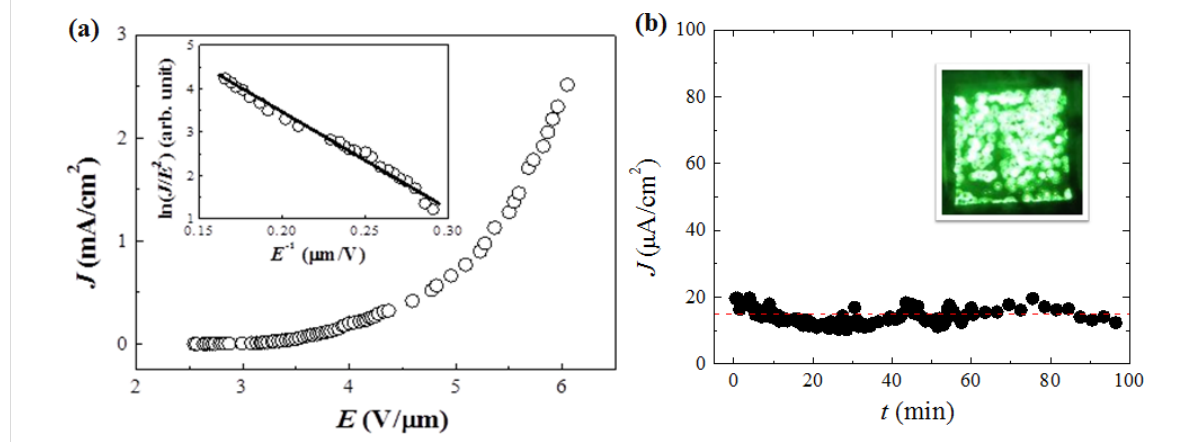
Figure 6: (a) Field-emission current density as a function of the electric field for the transferred MoS 2 NSs on FTO/glass. The inset shows the corre- sponding FN plot with a linear fitting used for estimating the field-enhancement factor. (b) The long-term field-emission stability for the same sample at the pressure of ca. 10 − 6 mbar with luminance from the sample.